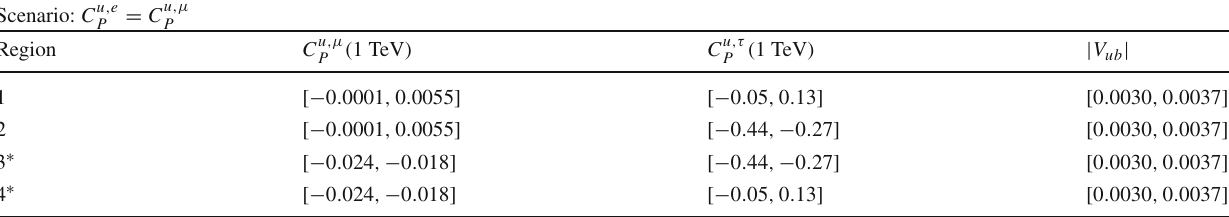
,μ C u . The regions marked by the asterisk are fully excluded by the P experimental upper bound on B ( B − → e − ¯ ν e ) u , e = P